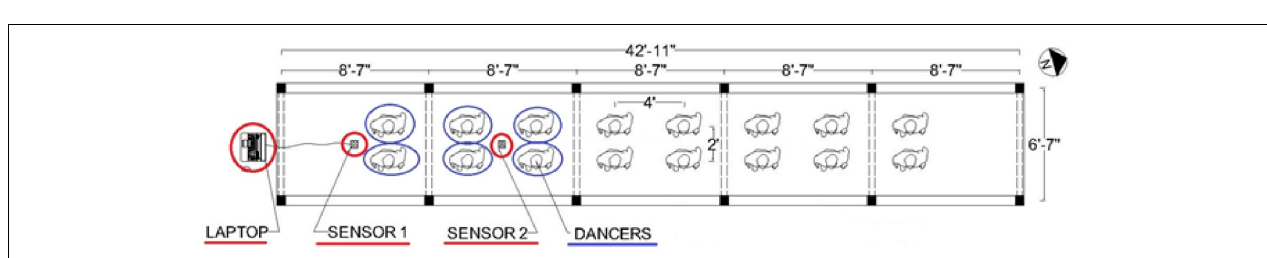
Frontiers in Built Environment |